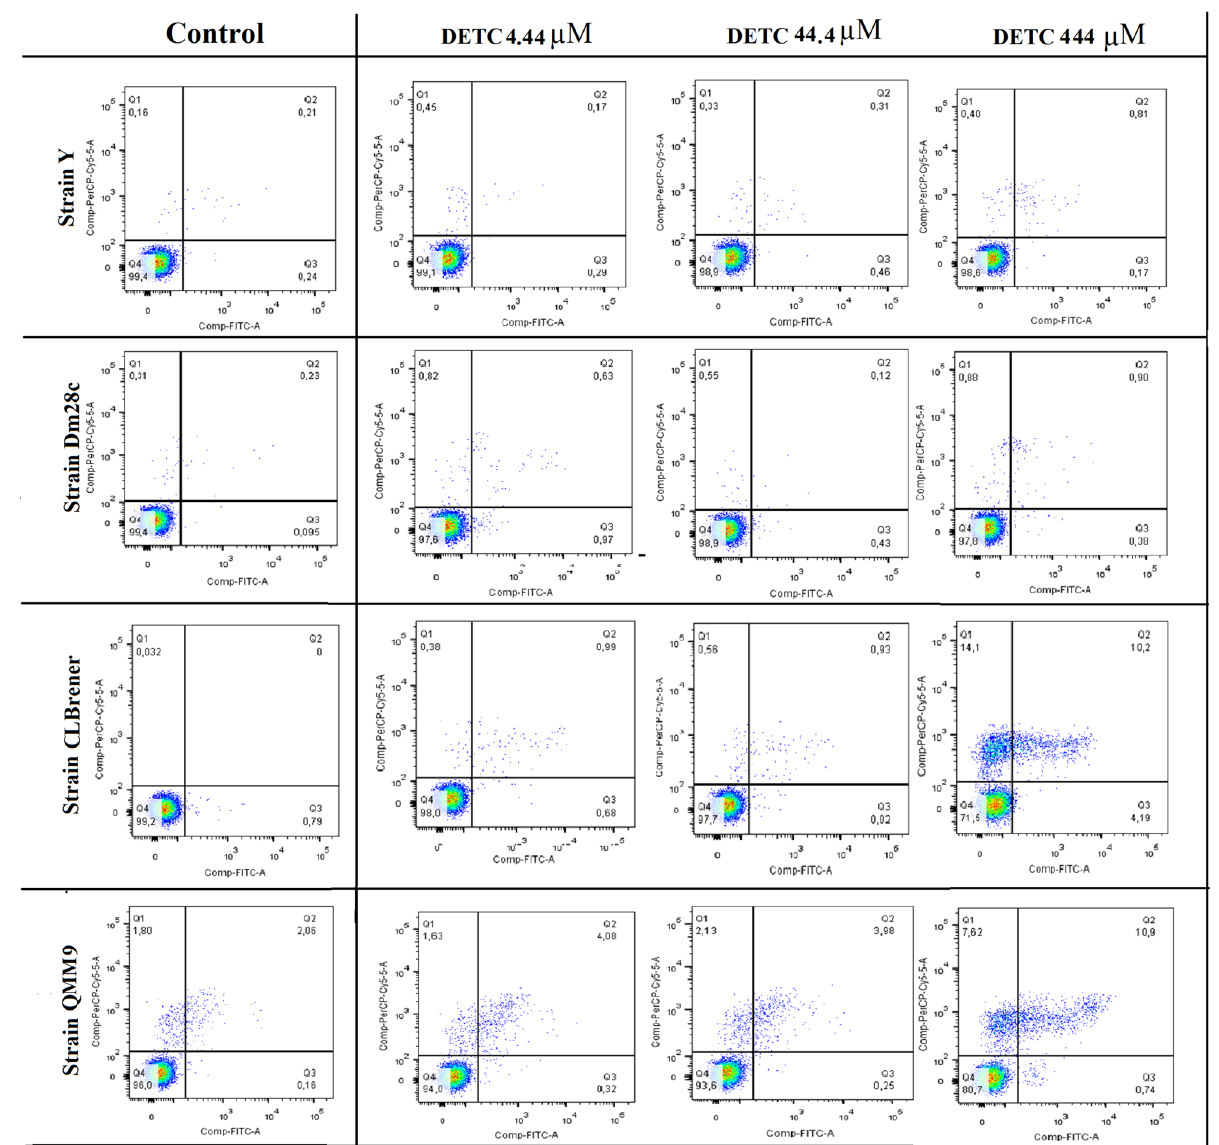
Figure 4. Analysis of the cell death mechanism of trypomastigotes from different Trypanosoma cruzi strains treated with DETC. The parasites death cell mechanism was evaluated by flow cytometry as to the capacity for Annexin/PI stain after 24 h of treatment with different DETC concentrations; 4.44 µM; 44.44 µM; and 444.00 µM. Flow cytometer (FACSCanto II, BD Biosciences, Eugene, OR, USA) with FACSDiva software, version 6.1.2 (Becton Dickson, Franklin Lakes, NJ, USA) (https:// www. bdbio scien ces. com/ en- us/ instr uments/ resea rch- instr uments/ resea rch- softw are/ flow- cytom etry- acqui sition/ facsd iva- softw